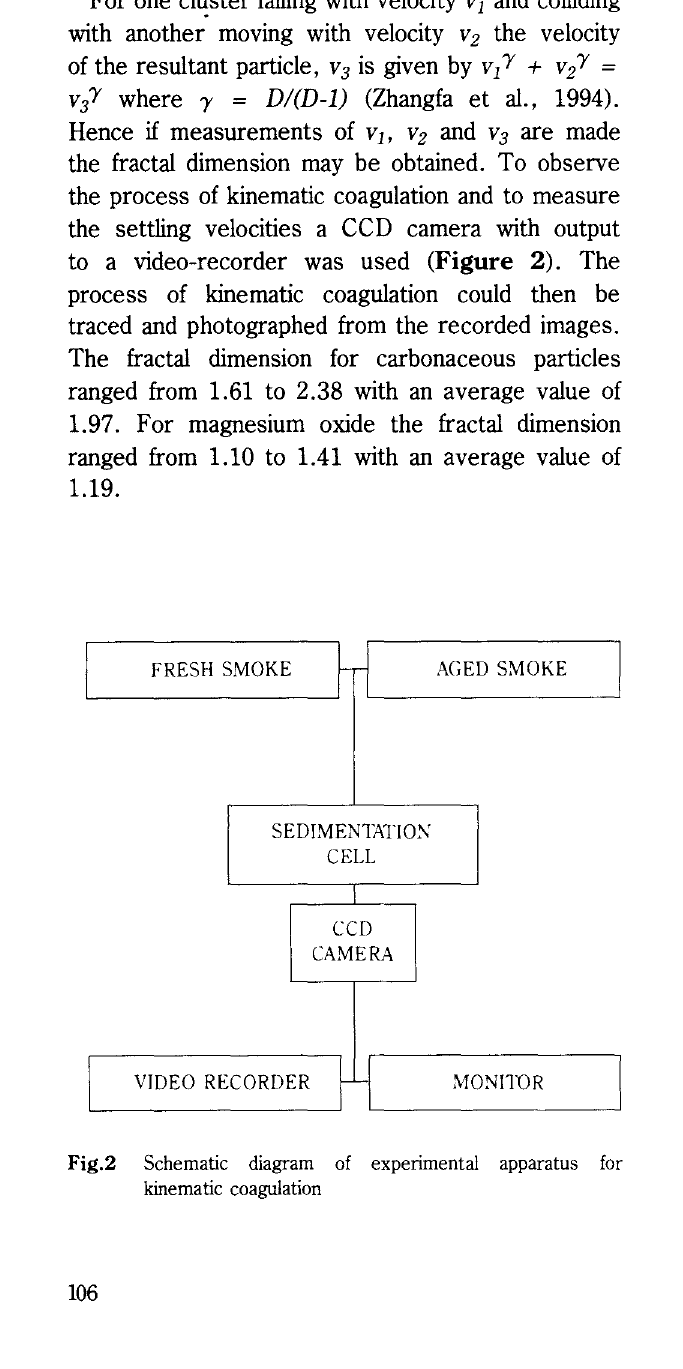
Fig.2 Schematic diagram of experimental apparatus for kinematic